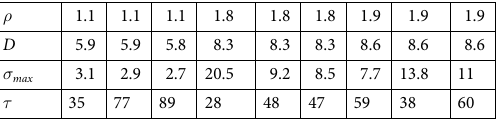
Table 1. Experimental data for